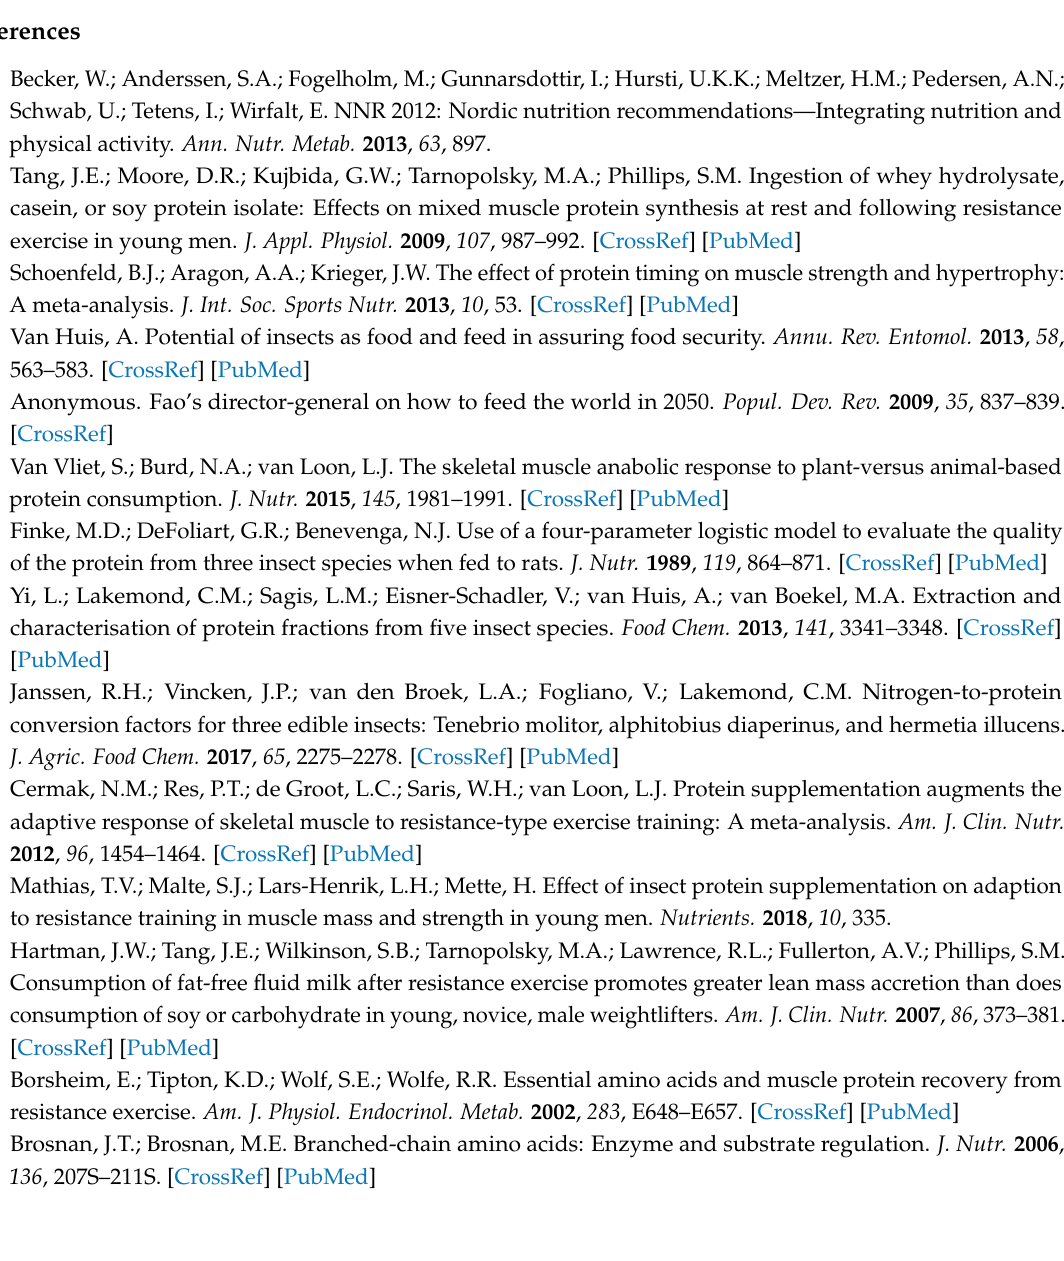
Figure 5: Adjusted blood amino acid concentrations of essential amino acids (EAA), branched-chain amino acids (BCAA) and Leucine after ingestion of whey, soy or insect protein